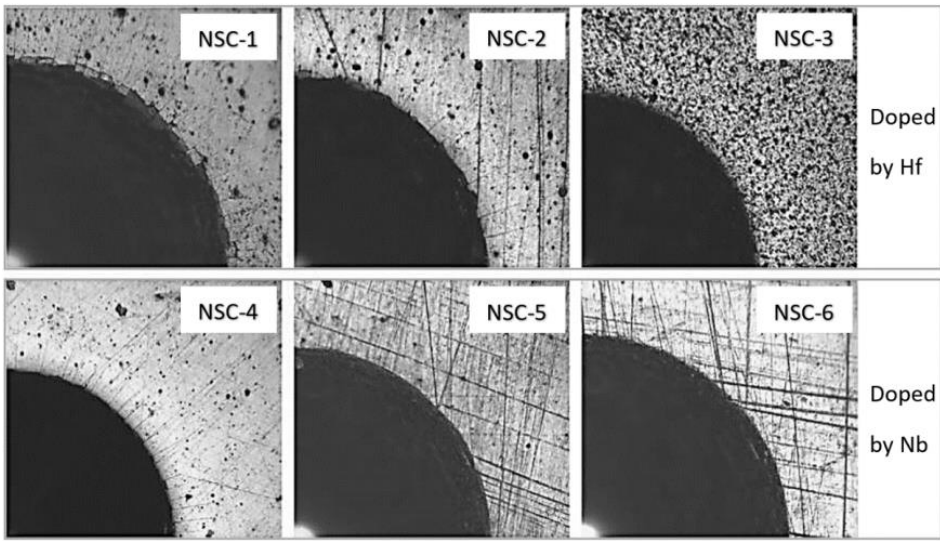
Figure 4. Adhesion assessment of the NSC samples by the Rockwell indentation hardness using the Rockwell C-scale, i.e., by the HRC test. The 90° sectors of the HRC test imprints are shown to demonstrate the coating’s adhesion according to DIN 4856: 2018 -02.